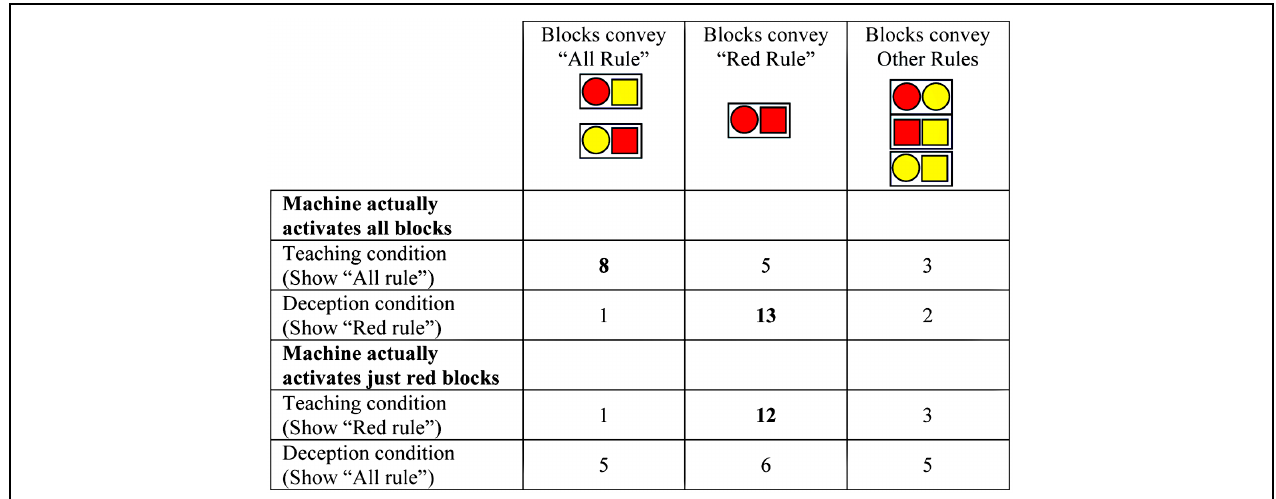
FIGURE 2 | Number of children choosing blocks in the Teaching and Deception conditions. Two possible block pairings convey the “All Rule”; one pair conveys the “Red Rule”; three remaining pairs convey other rules. (Probability of randomly selecting blocks consistent with “All Rule” = 2/6, “Red Rule” = 1/6, “Other Rules” =